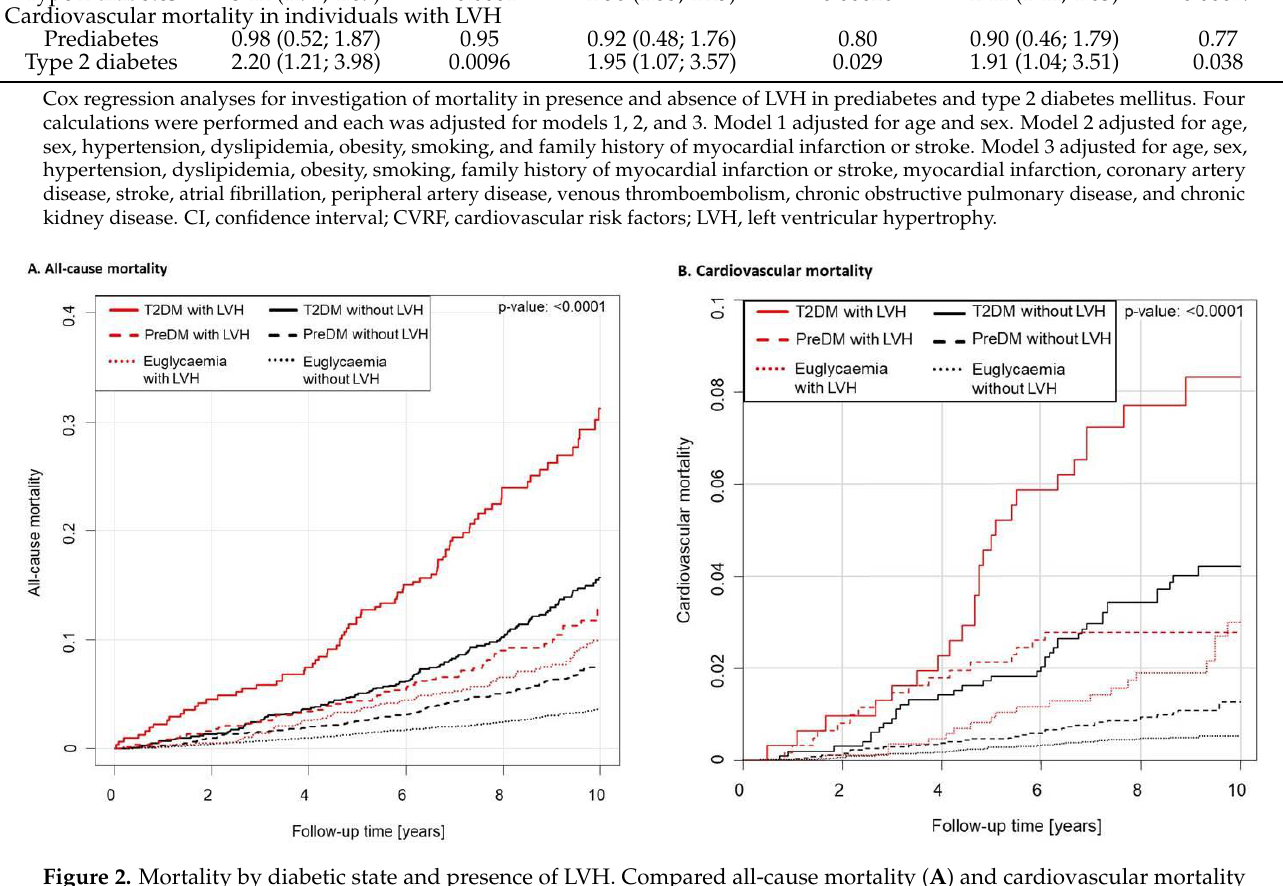
Table 3. Influence of left ventricular hypertrophy on mortality in prediabetes and type 2 diabetes mellitus. Model 1: Age, Sex Model 2: Add. Traditional CVRF Cox regression analyses for investigation of mortality in presence and absence of LVH in prediabetes and type 2 diabetes mellitus. Four calculations were performed and each was adjusted for models 1, 2, and 3. Model 1 adjusted for age and sex. Model 2 adjusted for age, sex, hypertension, dyslipidemia, obesity, smoking, and family history of myocardial infarc- tion or stroke. Model 3 adjusted for age, sex, hypertension, dyslipidemia, obesity, smoking, family history of myocardial infarction or stroke, myocardial infarction, coronary artery disease, stroke, atrial fibrillation, peripheral artery disease, venous thromboembolism, chronic obstructive pulmonary disease, and chronic kidney disease. CI, confidence interval; CVRF, cardiovascular risk factors; LVH, left ventricular hypertrophy.